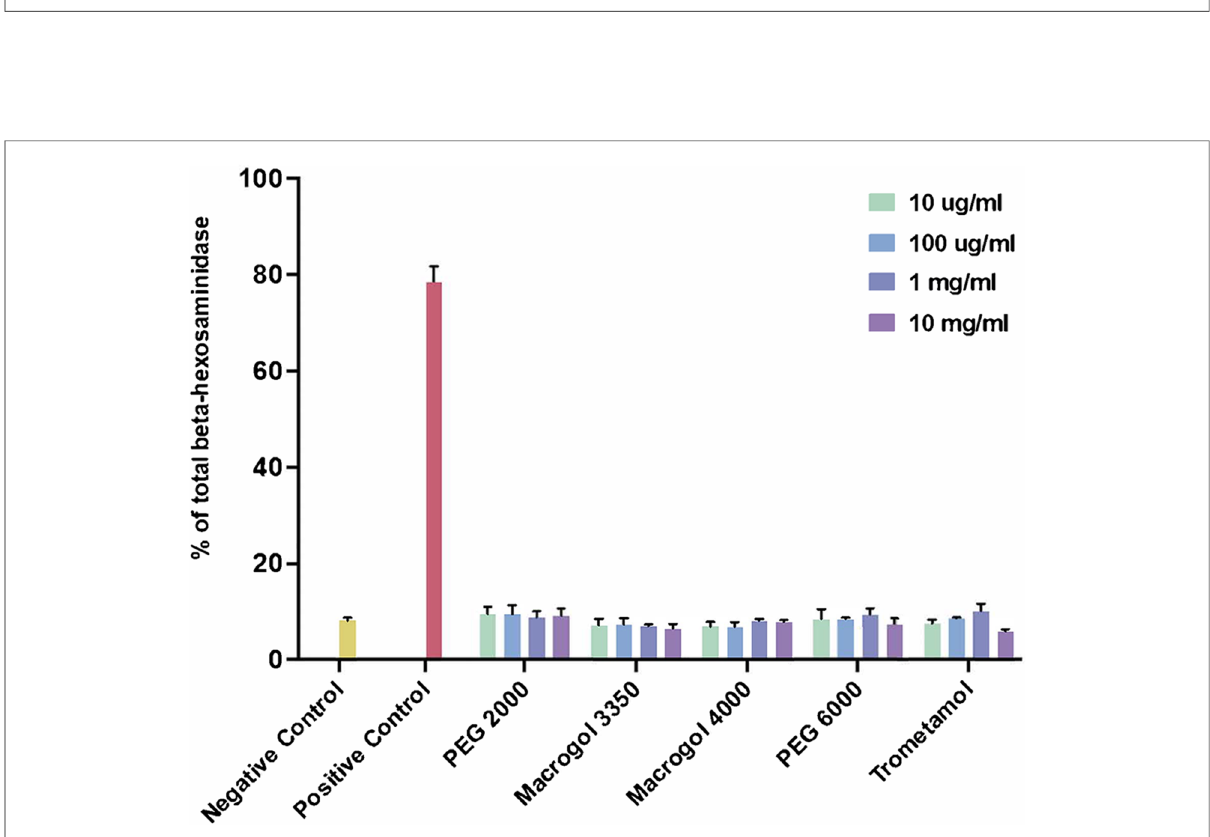
FIGURE 2 Percentage of total beta-hexosaminidase release after incubation with reagents (polyethylene glycol/macrogol and trometamol) at different concentrations. Unstimulated cells were used as a negative control (basal degranulation), cells stimulated with phorbol 12-myristate 13-acetate (PMA) (10 ng/ml) and ionomycin (0.5 µM) were used as a positive